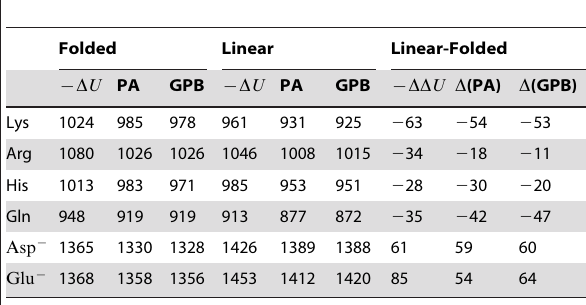
Table 4. Thermodynamic data for the protonation reaction of the side chain of some amino